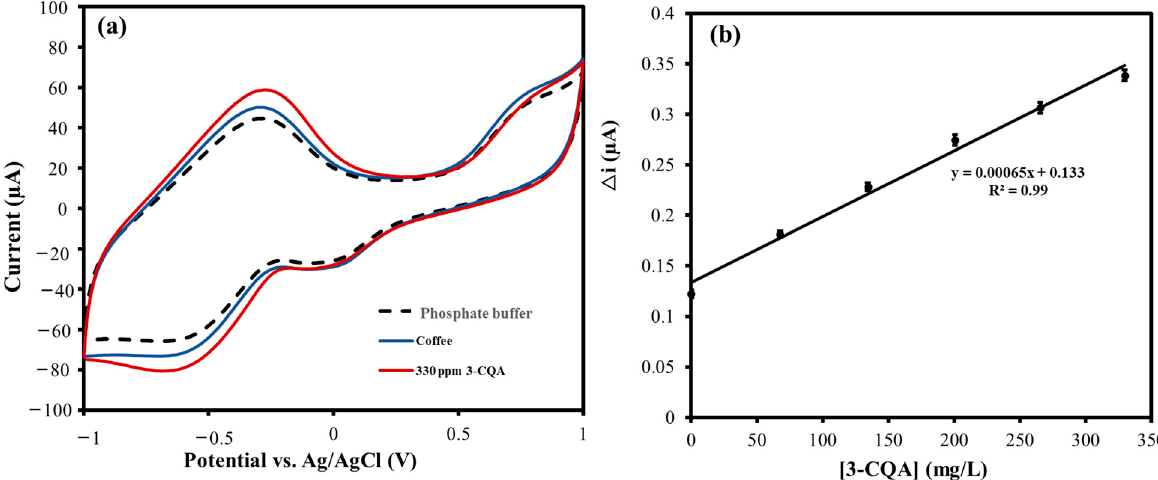
Figure 10. ( a ) Overlaid CVs obtained from the analysis of 0.10 M phosphate buffer blank, coffee (in 0.1 M phosphate buffer), and 330 mg/L 3-caffeoylquinic acid (3-CQA) (in 0.10 M phosphate buffer) taken using the PANI@CNT/CNC SPME MN. ( b ) Associated 3-CQA concentration vs. △ Current standard addition plot.